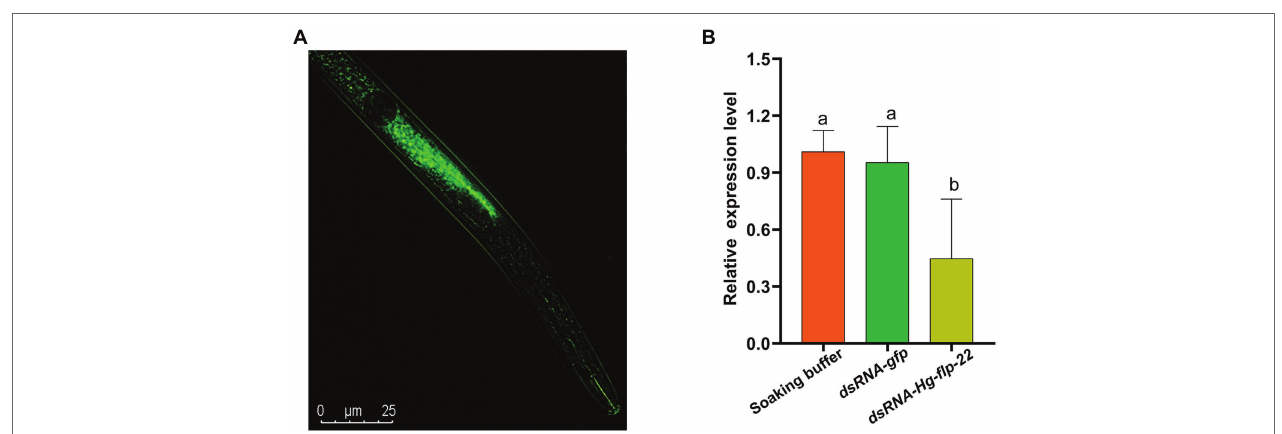
FIGURE 3 | (A) Fluorescence microscopy indicating uptake of fluorescein isothiocyanate (FITC) in dsRNA buffer by H. glycines J2s after 24 h incubation. (B) Pre- parasitic J2s were incubated in the socking buffer, Hg-flp-22 dsRNA, or gfp dsRNA for 24 h. Then, the Hg-flp-22 transcript levels in nematodes were analyzed by qRT-PCR. The results are the means ± SD of three biological replicates shown relative to expression in J2s maintained in the socking buffer. The same letters indicate no significant differences between treatments ( p > 0.05, Tukey’s HSD